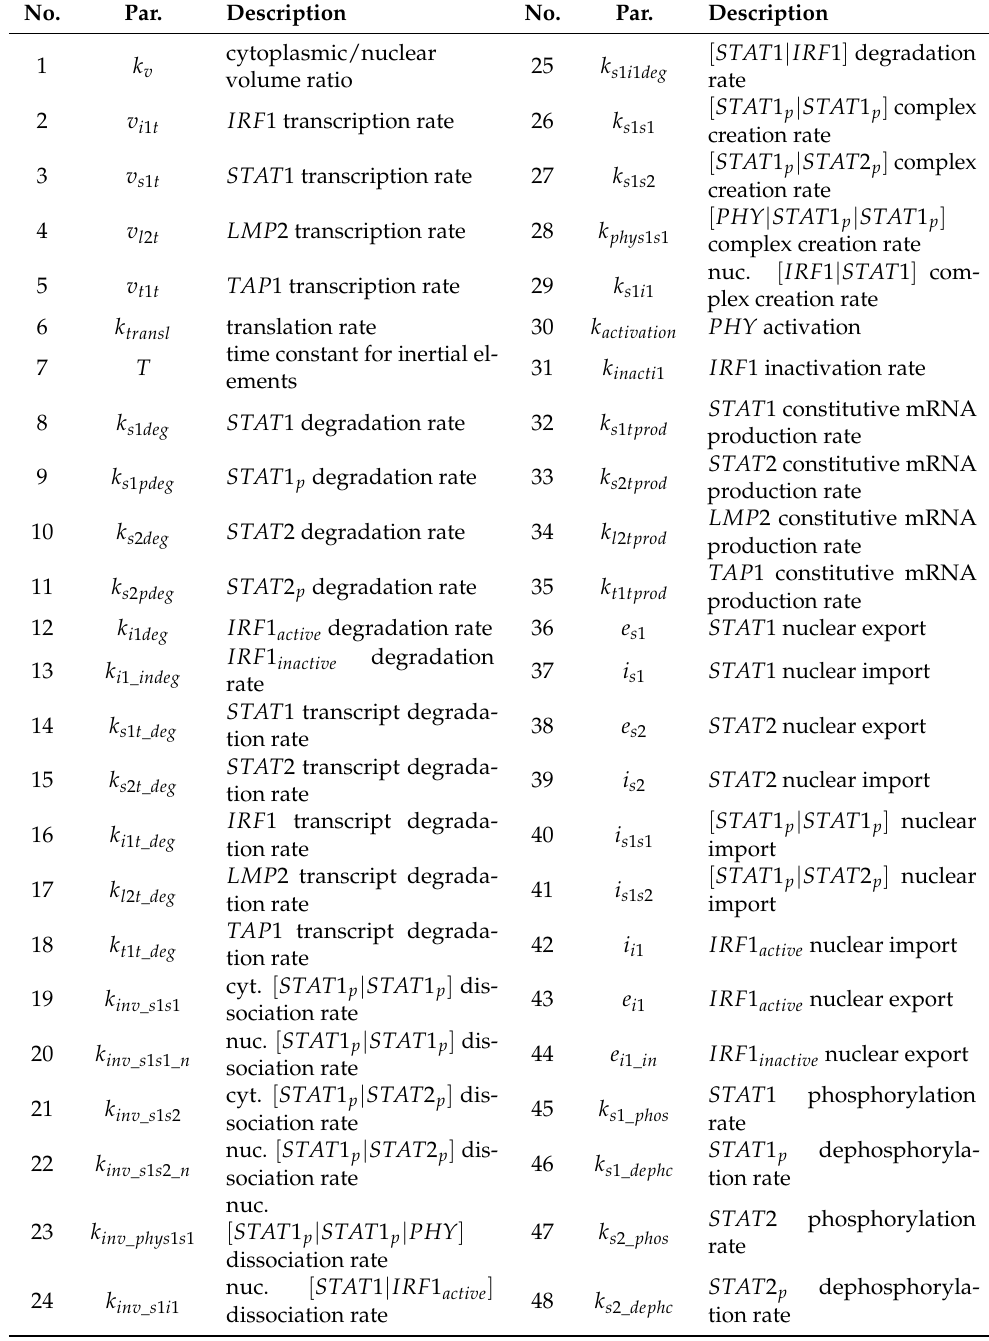
Table 2. List of parameters appearing in the IFN- β -induced JAK/STAT signaling pathway model [1]. No. Par. Description No. Par.